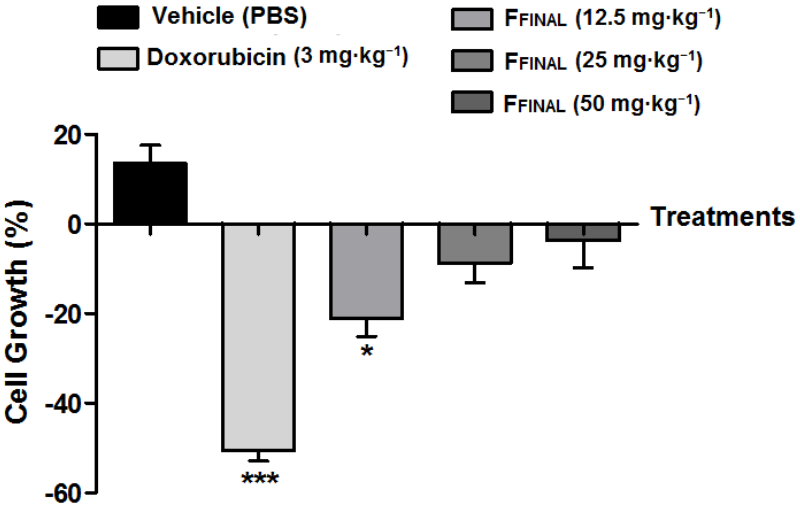
Figure 9. MCF7 cell proliferation, in Hollow fiber as a function of treatments. Results expressed as mean ± standard deviation; Female Balb / c mice ( n = 5 animals / group). Treatments (orally every day): vehicle (PBS pH 7.0 + Tween 80, 10 mL · kg − 1 ), F FINAL (12.5, 25, and 50 mg · kg − 1 ); Treatments (i.p., every three days): Doxorubicin (3 mg · kg − 1 ). Statistical analysis by One-Way ANOVA, followed by Tukey’s